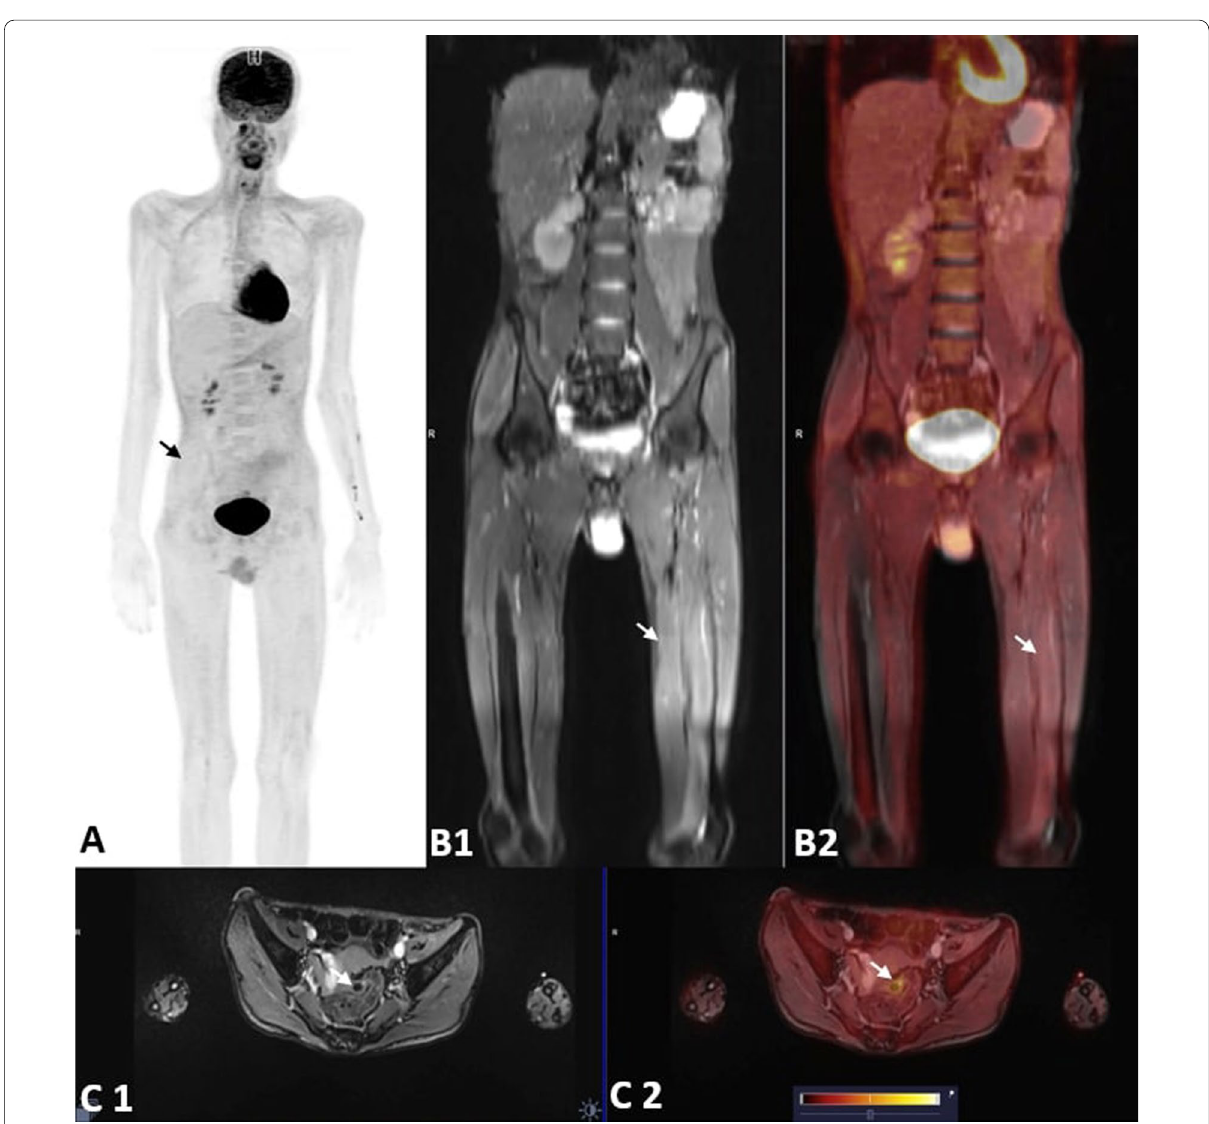
Fig. 2 PET‑MRI images of a 16‑year‑old boy with Overlap Myositis. A Whole body MIP image (black arrow). B1 Coronal T2 FS BLADE MR image showing hyperintensity changes in the muscles around hip and lower limbs (white arrow). B2 Coronal fused PET/MRI image shows increased FDG uptake in all the muscles at HIP and lower limbs (white arrow). C1 and C2 . Axial T2FS BLADE MR showing subtle hyperintensity changes in the gluteal muscles (white arrow). Axial Fused PET/MR images showing mild diffuse increased FDG uptake in gluteal muscles (white